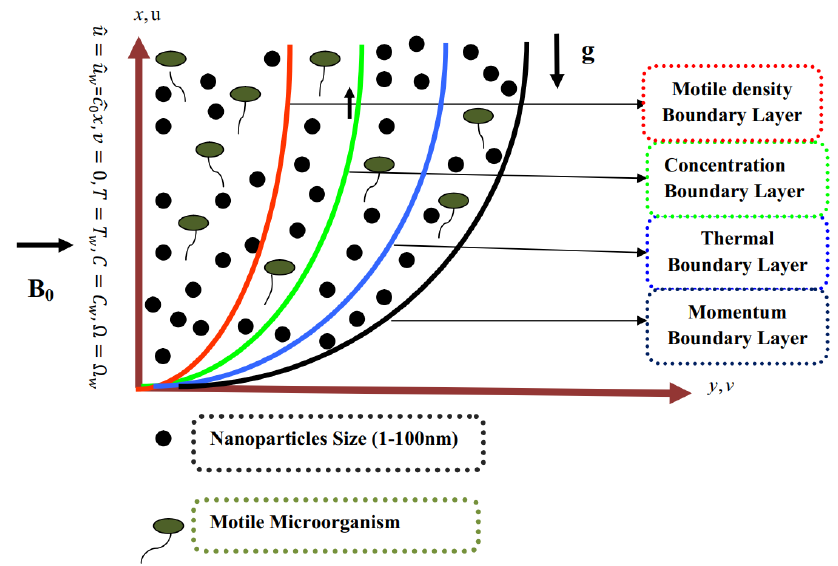
Figure 1. Geometry of problem.